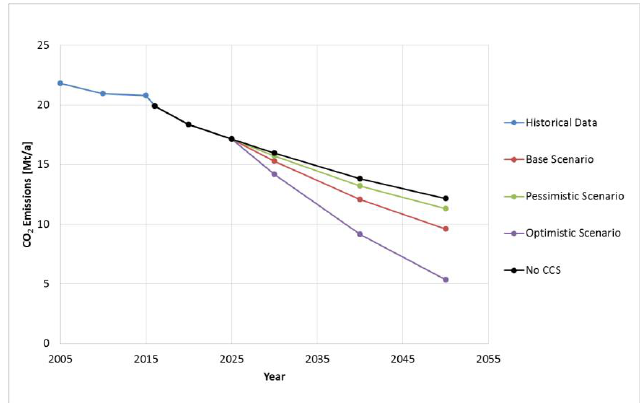
Figure 9. CCUS Germany: CO 2 emission projections for low clinker production. (historical data from UBA/VDZ [21,51]).